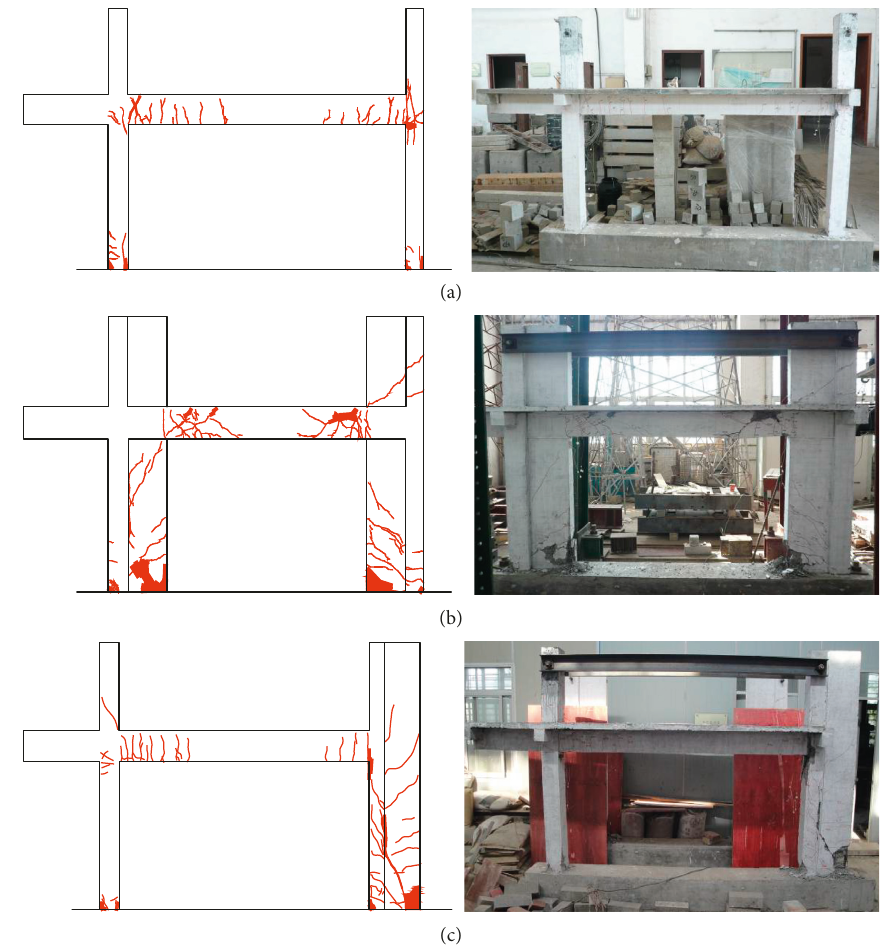
Figure 5: Photographs and crack patterns of specimens after the test: (a) specimen S1; (b) specimen S2; (c) specimen